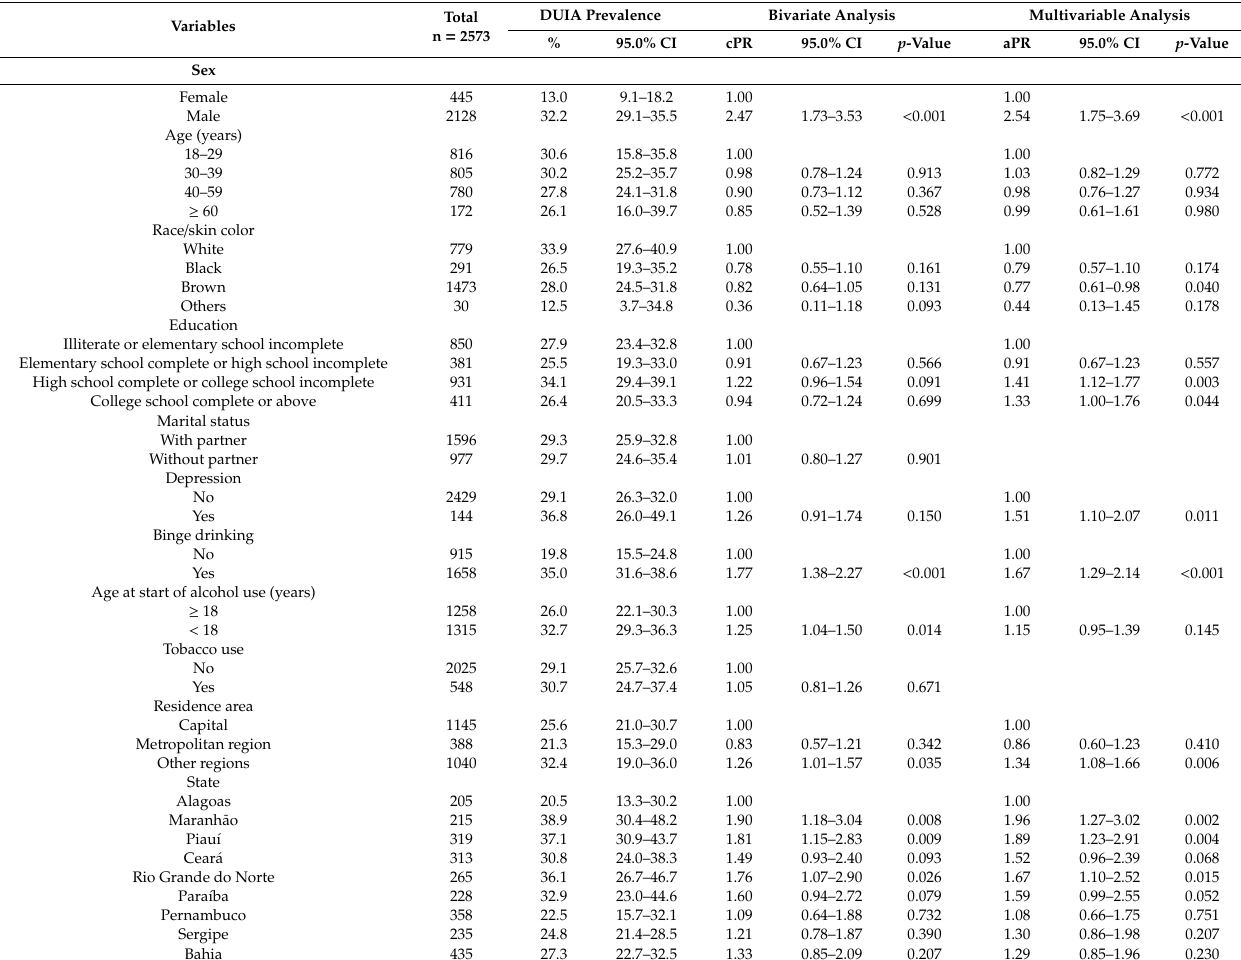
Table 5. Prevalence and Factors Associated with Driving Under the Influence of Alcohol in the Northeast Macroregion, Brazil. National Health Survey, 2013. DUIA Prevalence Bivariate Variables Total n = 2573